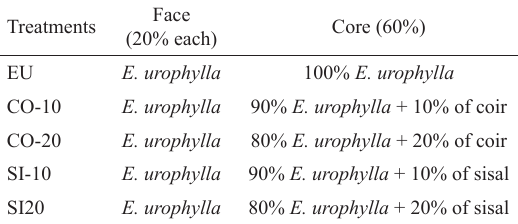
Table 1: Treatments with their composition.